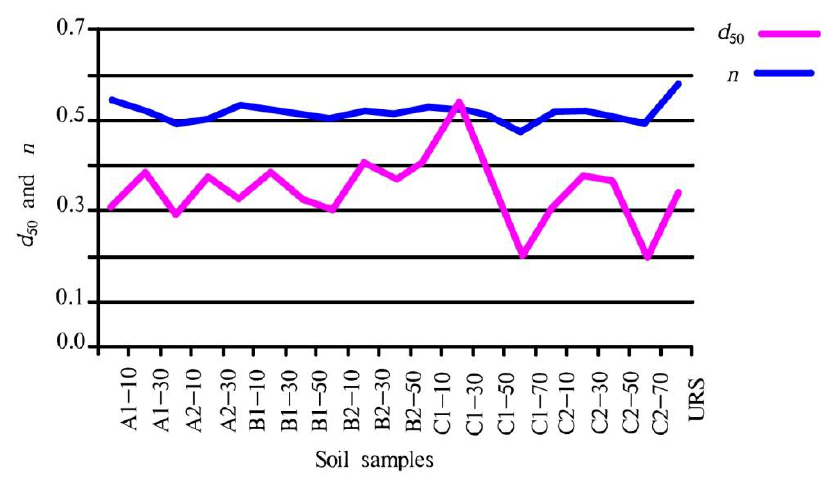
Figure 18. Scatter plot with straight lines of d 50 and n .